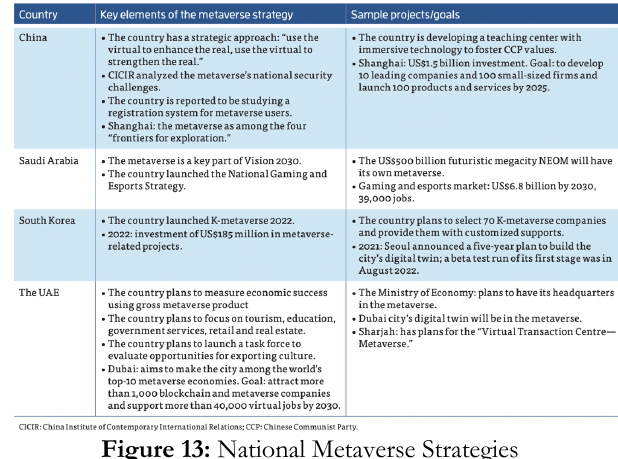
Figure 13: National Metaverse Strategies Computing’s Economics,